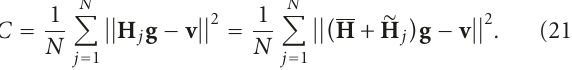
Figure 13: Performance as a function of the regularization param- eter for position variations of r = 1,2,3 and 4cm ( d = 500). Filter length was set at M = 1333 (a), and M = 1333 + 500 (b), respec-